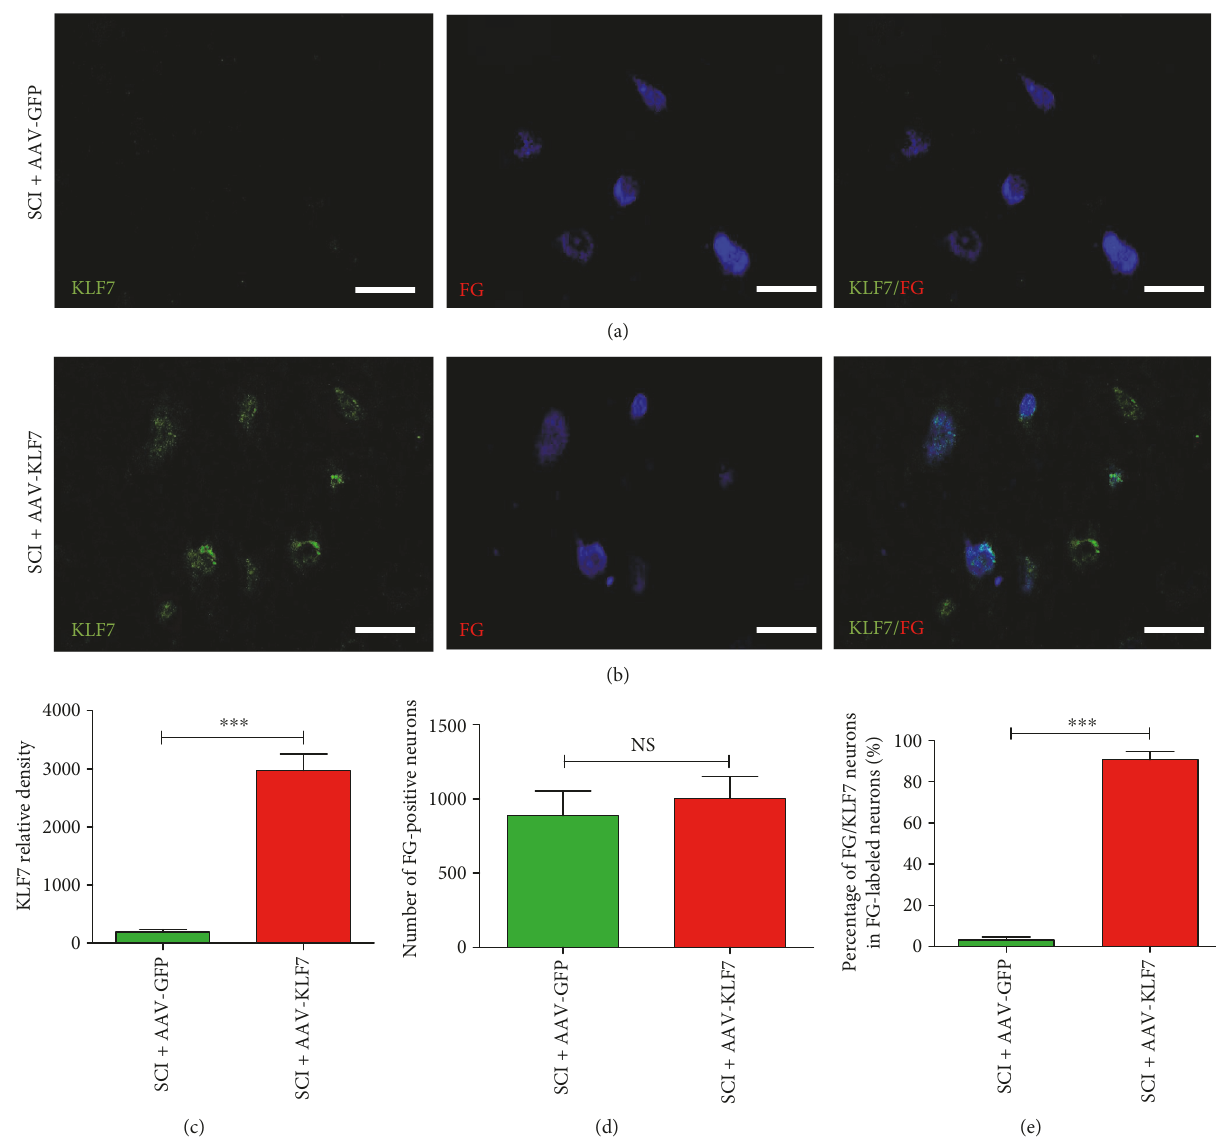
Figure 8: AAV-KLF7 signi fi cantly infects DPSNs at T7 and T9 levels after SCI. Five weeks after contusion injury, (a-b) representative immunohistochemical stainings for KLF7 (green) and FG (retrograde-labeled DPSNs, blue) in the Rexed lamina VII at the T7 and T9 levels are shown across the SCI +AAV-GFP and SCI +AAV-KLF7 groups. Cell counts were performed at the T7 and T9 levels with 15 sections per segment. Quantitative analyses of the KLF7 relative density (c), FG-labeled neurons (d), and percentage of FG/KLF7 double- labeled neurons (e) above the lesion area. n = 6 mice/group. Student ’ s t -tests; green indicates SCI +AAV-GFP control; red indicates SCI +AAV-KLF7. ∗∗∗ P < 0 001 . NS: not signi fi cant. Scale bars: 50 μ